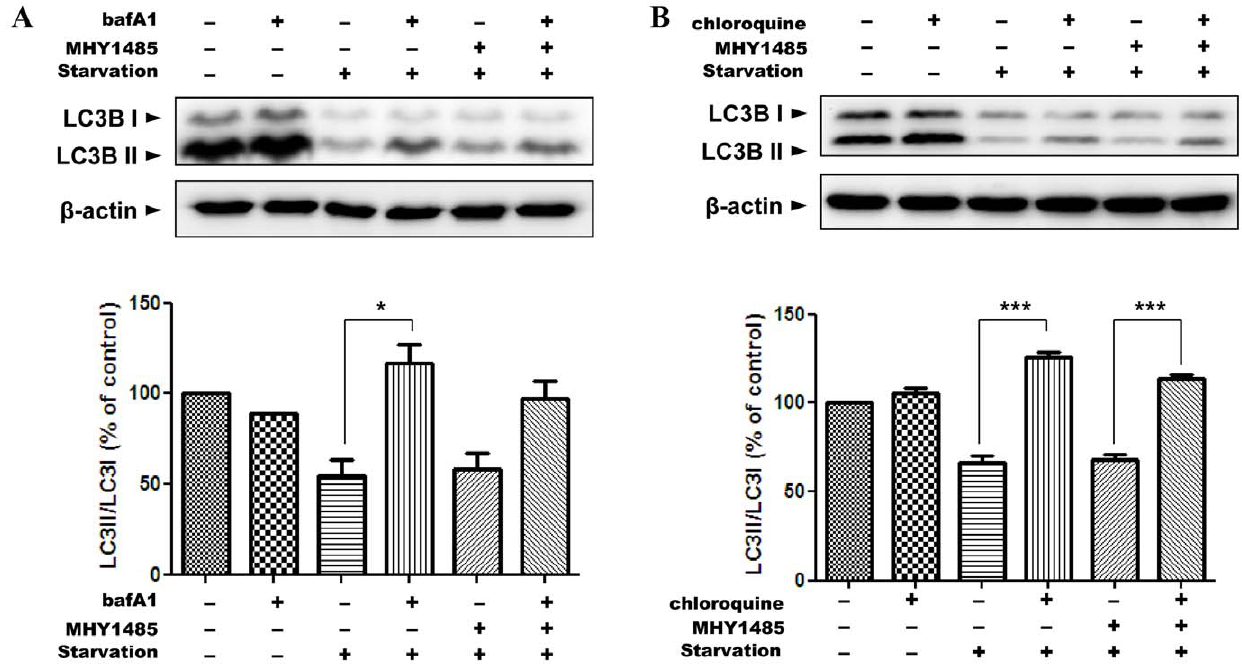
Figure 4. Inhibition of starvation-induced autophagic flux by MHY1485. Western blot analysis was performed to measure autophagic flux. Ac2F cells under starvation or co-treatment of 2 m M MHY1485 for 6 h were treated 1 h before the cell harvest with lysosomotropic agents bafilomycin A1 (10 nM) and chloroquine (100 m M) (A, B). Bars represent the LC3II/LC3I ratio normalized with the LC3II/LC3I ratio from untreated samples. b -Actin blot is shown to verify the same amount of protein loaded. The blots were quantified by densitometry expressed as mean 6 SD (*p , 0.05, ***p , 0.001; n=3).